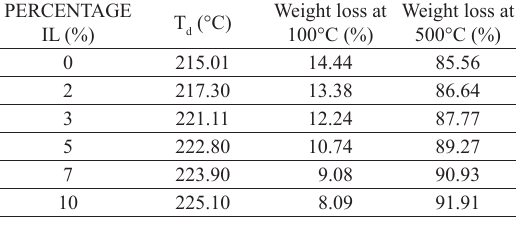
Table 2. TGA data for preared PET-IL blend Percentage IL